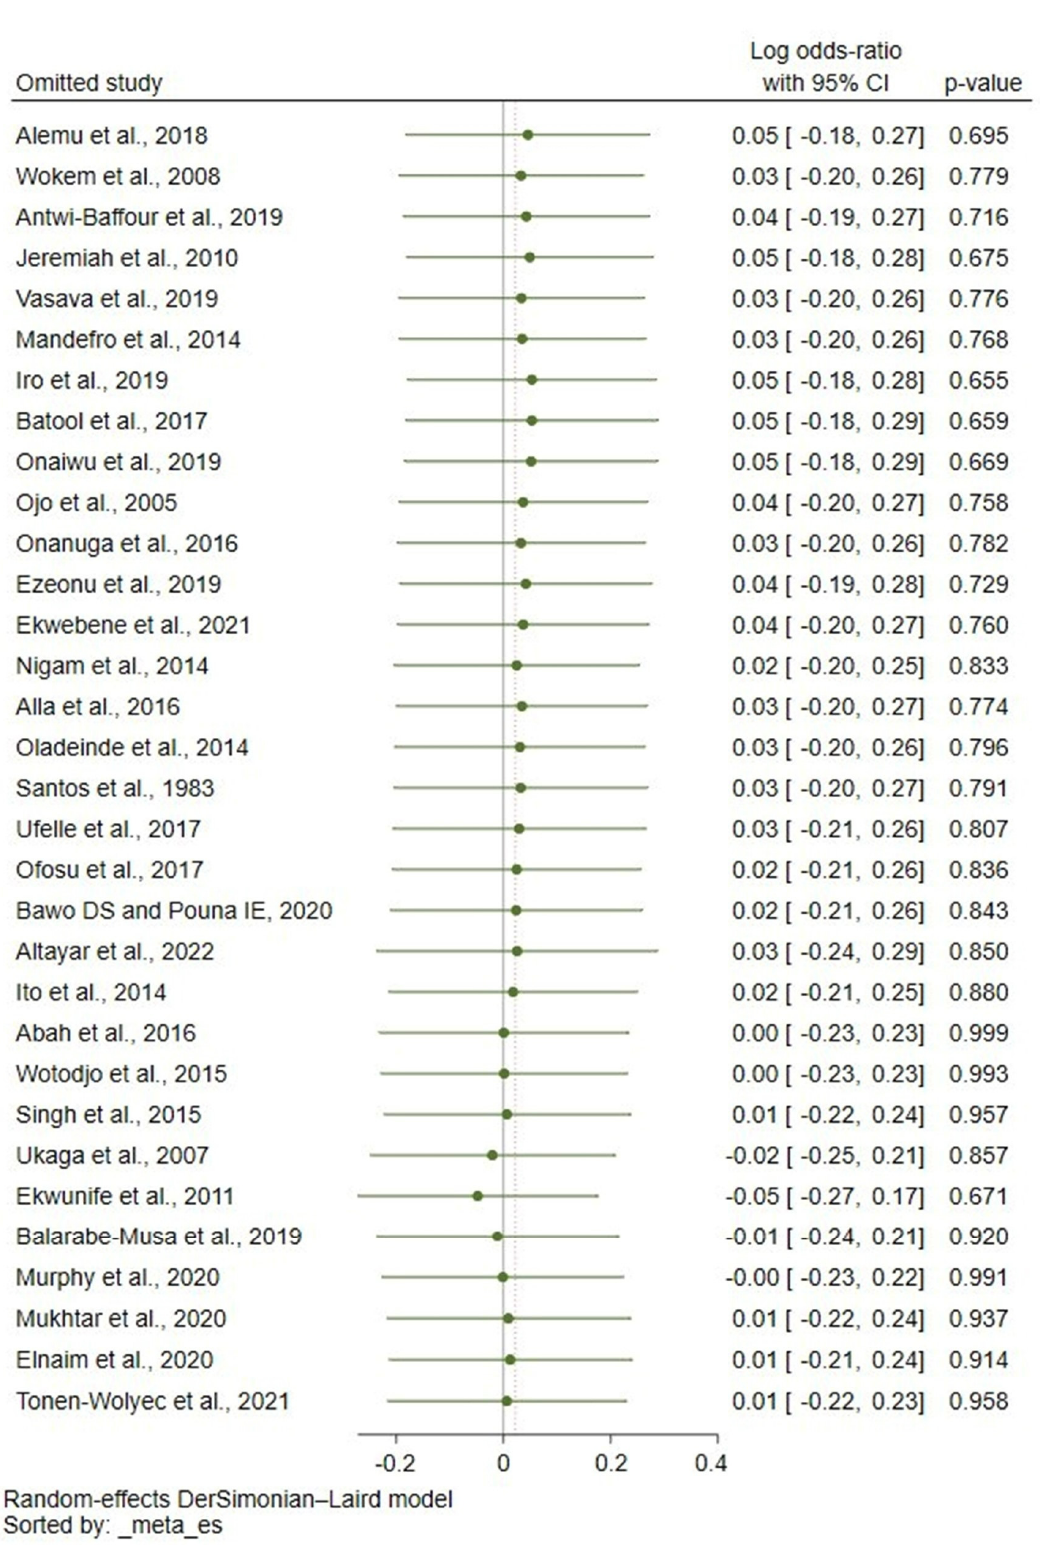
Figure 3. Sensitivity analysis demonstrating no individual study that affects meta ‐ analysis results. Abbreviations: CI, confidence interval. [21,23–27,29–34,37–56]